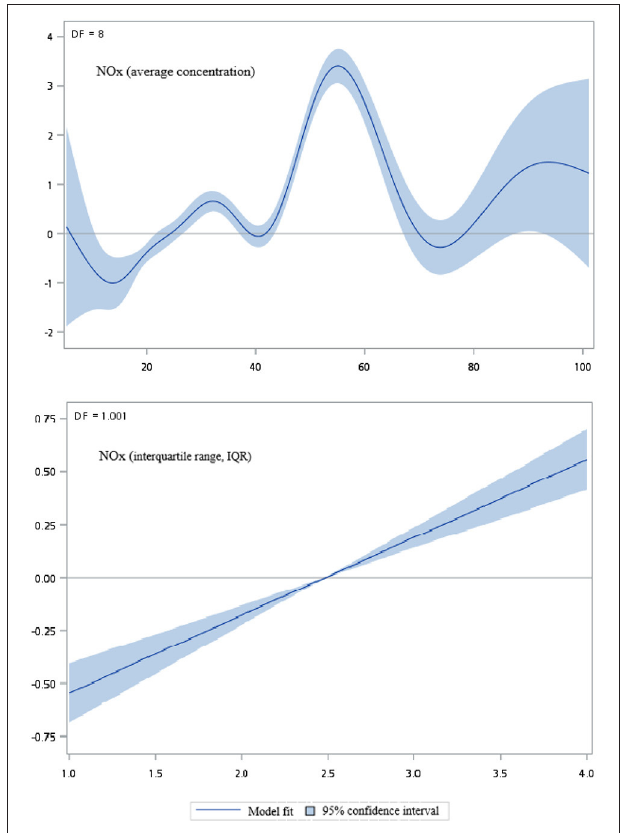
FIGURE 2 | Generalized additive model plot for air pollutions